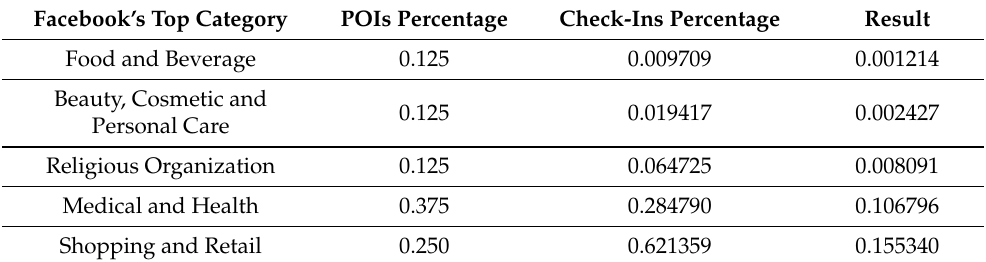
Table 4. Example of a region classification